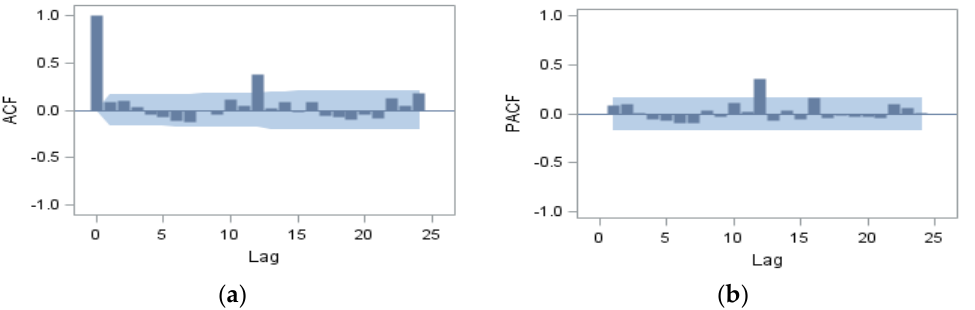
Figure 2. The acf and pacf of original time-series: Vibrio parahaemolyticus outbreaks. Gray area represents the two standard error limits; ( a ) the acf pattern; ( b ) the pacf pattern.